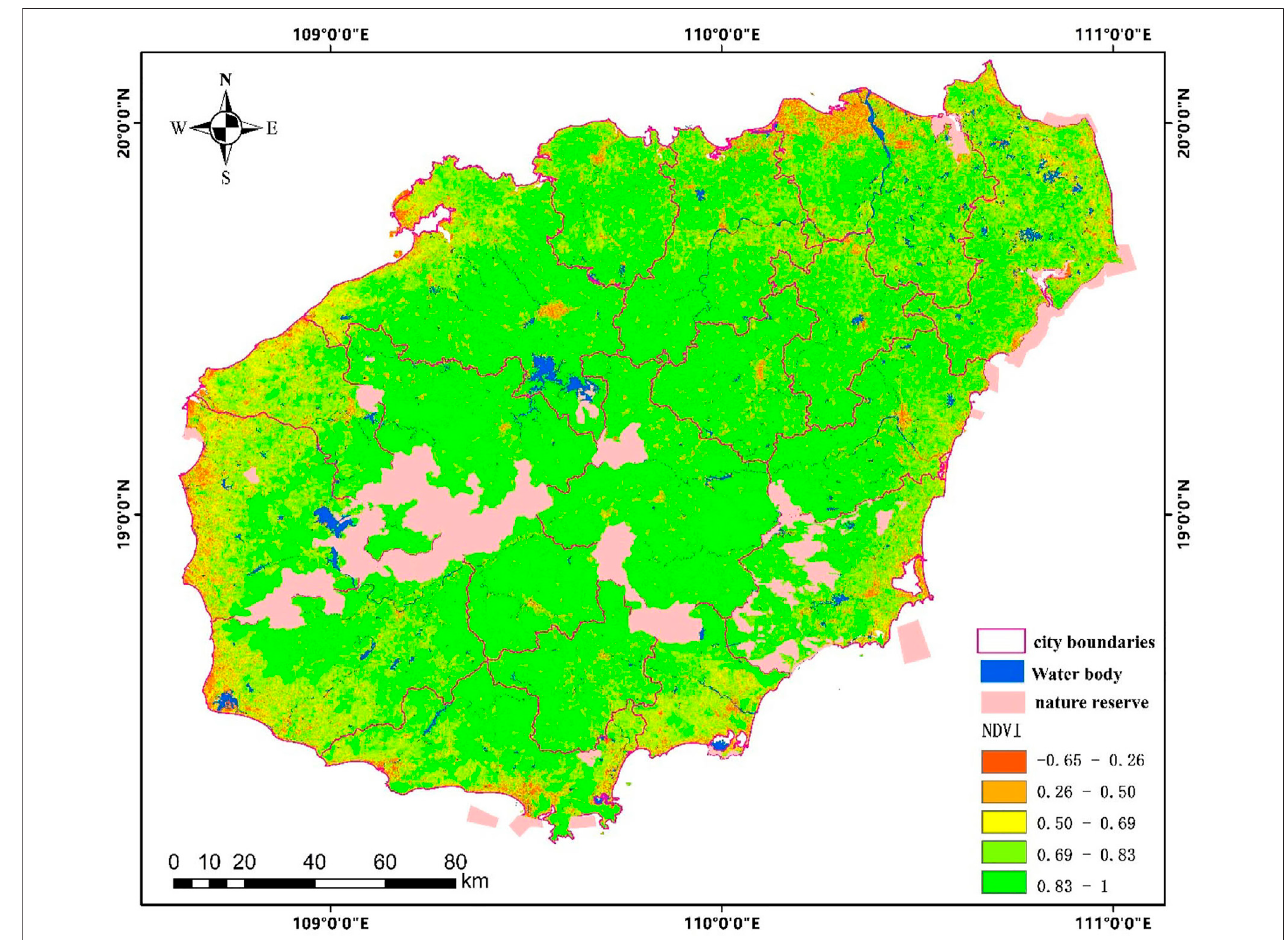
FIGURE 1 | Spatial distribution of Hainan Island natural reserves. The pink area shows the spatial distribution of the study area. The boundary data come from the Hainan Academy of Environmental Sciences.